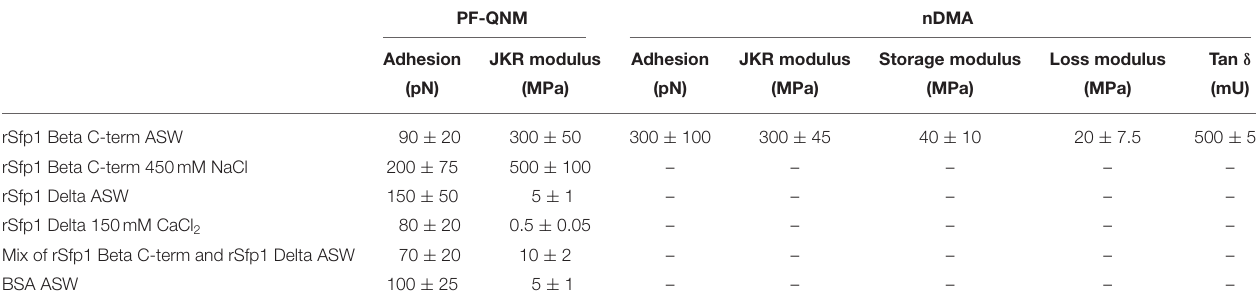
TABLE 2 | Peak Force Quantitative Nanomechanical Property Mapping (PF-QNM) and nanoscale dynamic mechanical analysis (nDMA) of rSfp1